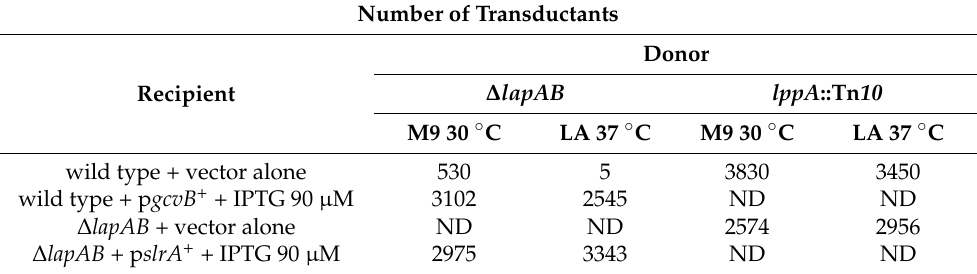
Table 5. Overexpression of GcvB suppresses lethality of a ∆ ( lapA lapB ) derivative. Determination of the viability of ∆ ( lapA lapB ) derivatives in the presence of the vector alone or when the expression of either gcvB sRNA or slrA sRNA is induced. Numbers indicate the number of transductants using the equivalent amount of recipient. ND: not